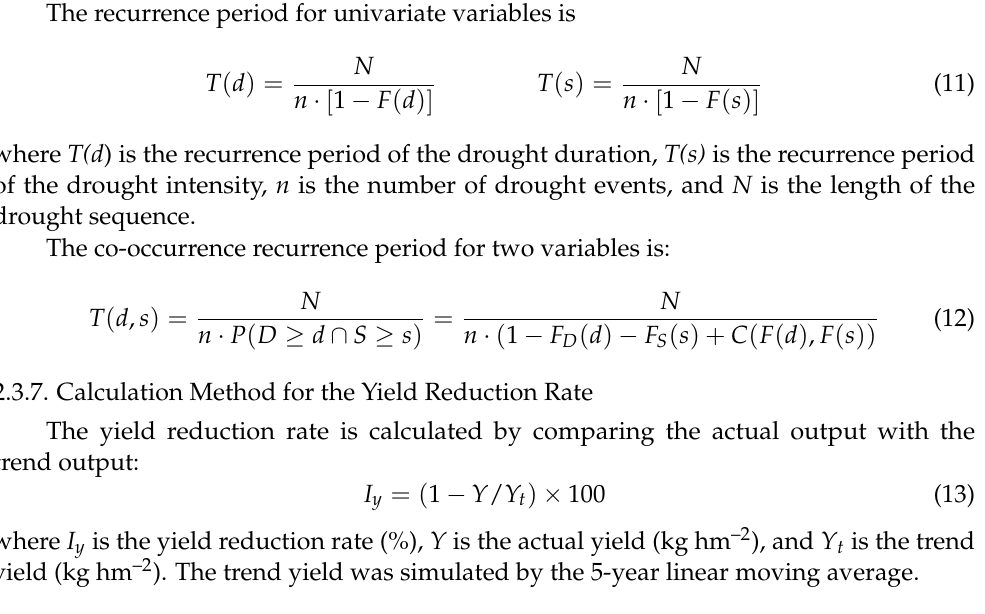
Figure 4. Development of a maize drought disaster at Fuxin station in 2006.